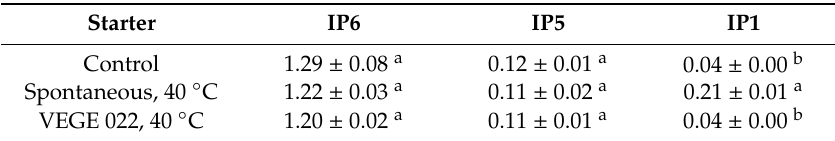
Table 2. Inositol phosphates content [% dwb] measured with the LC-MS method in powders fermented by di ff erent starter cultures. Standard deviations are shown ( n = 3). Values sharing a letter within a column are not statistically di ff